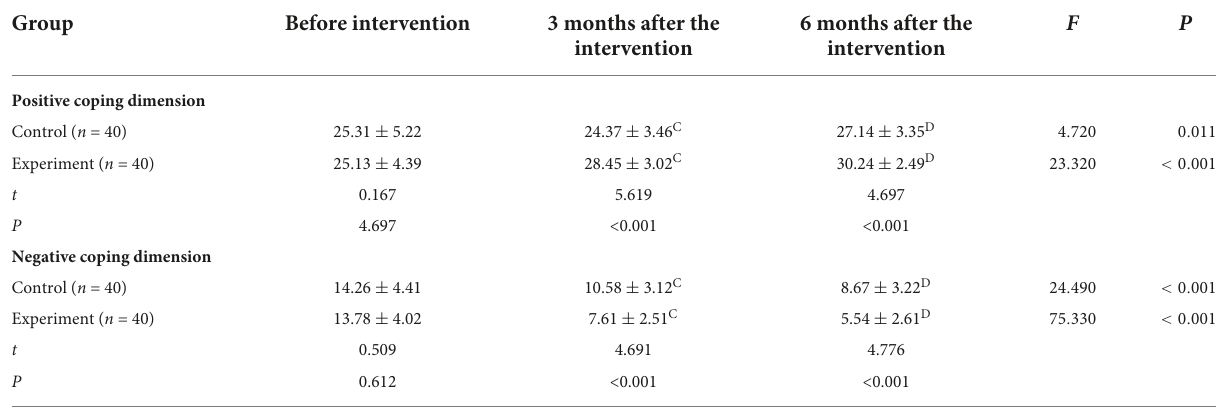
TABLE 3 Comparison of simplified coping style questionnaire (SCSQ) scores between the two groups before and after intervention (x ± s). Group Before intervention